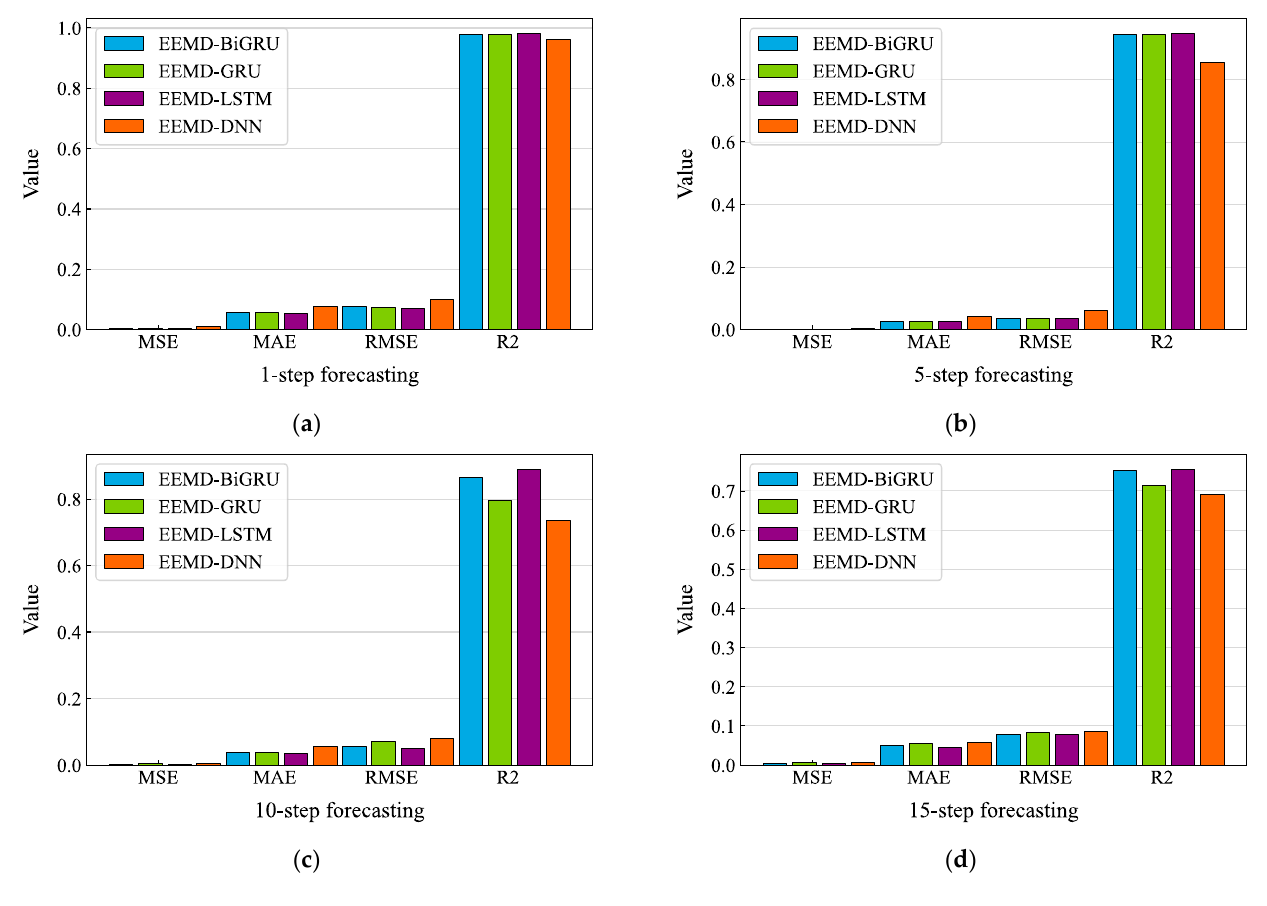
Figure A2. Evaluation metric comparison results for the El-Centro dataset using the EEMD-based algorithms: ( a ) 1-step forecasting of the four hybrid models; ( b ) 5-step forecasting of the four hy- brid models; ( c ) 10-step forecasting of the four hybrid models; ( d ) 15-step forecasting of the four hybrid models. Table A2. Comparison results for the RG dataset using different